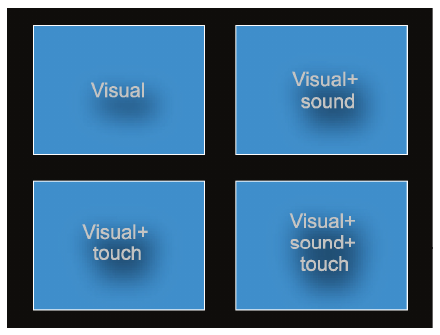
Figure 7: Touchscreen feedback introduction